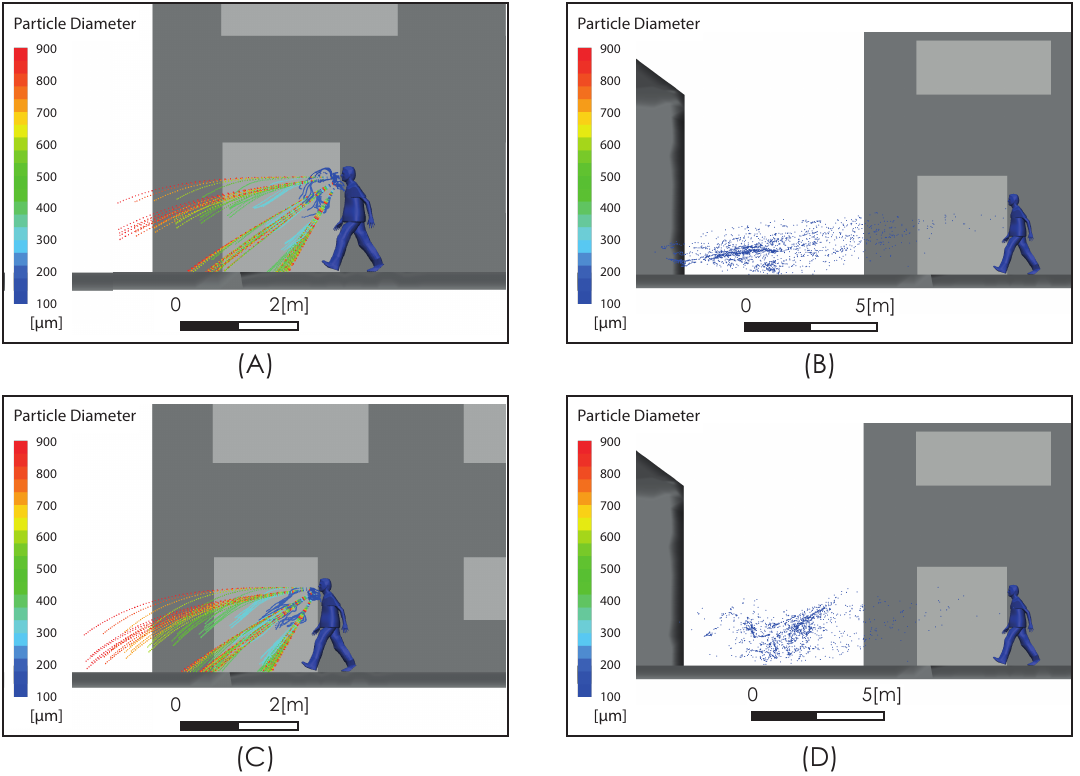
Figure 9. Respiratory droplet propagation during sneeze at t = 0.6 s ( A , C ) and after sneeze at t = 5 s ( B , D ). Moderate intensity airflow of 2 m/s ( A , B ) and intense airflow of 4 m/s ( C , D ).